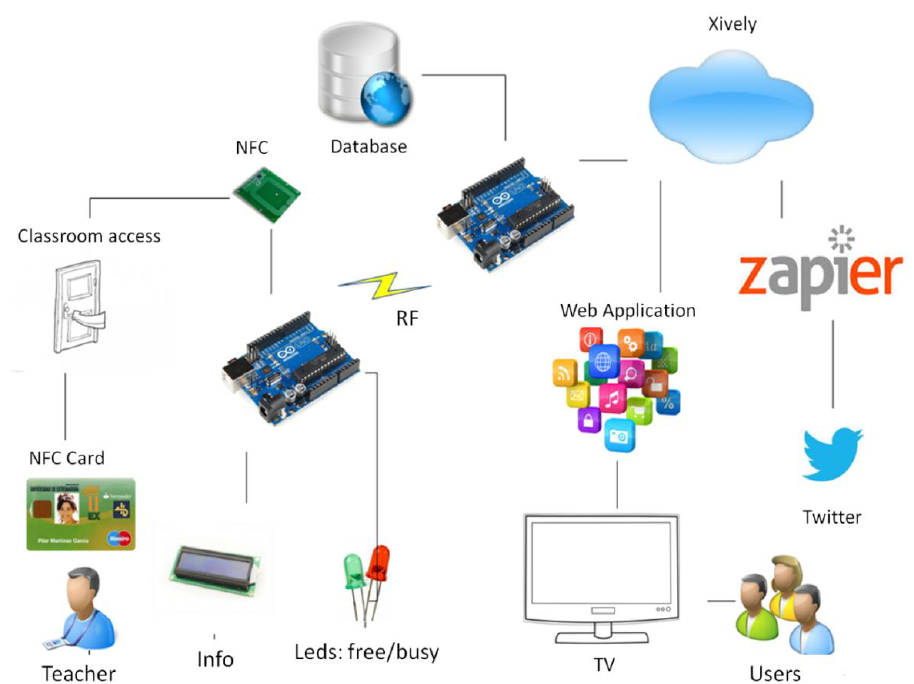
Figure 3. Overall